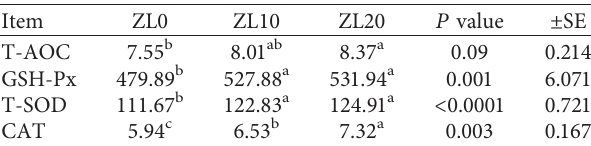
Table 6: Effects of dietary ZL supplementation on antioxidants in the blood of growing rabbits.